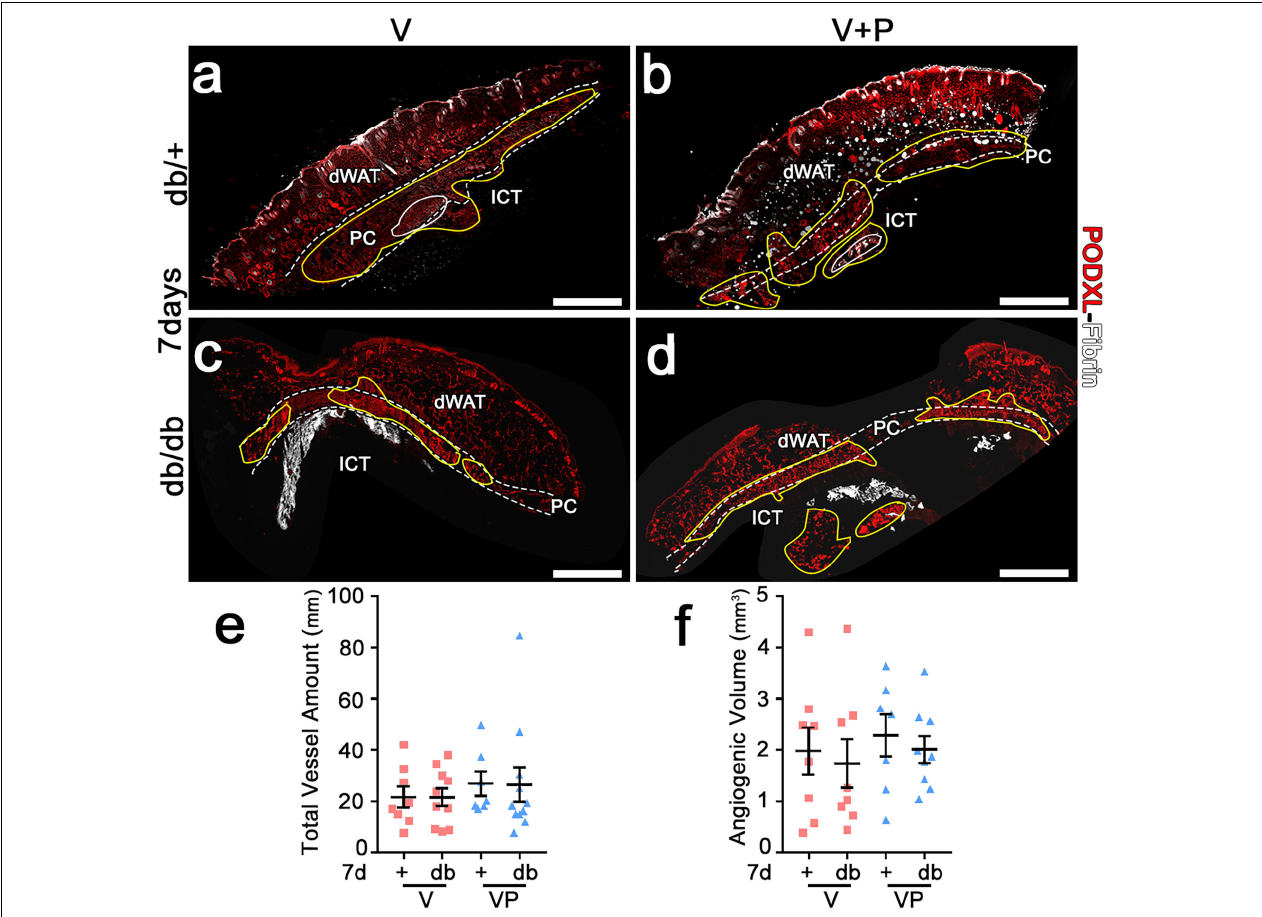
FIGURE 4 | Both VEGF alone and with PDFG-BB enable similar amounts of vascular growth in diabetic skin as in healthy mice. (a–d) Immunostaining for podocalyxin (endothelial cells, red) and fibrin (white) was performed on cryosections of dorsal skin of normal heterozygous (db/+) and diabetic (db/db) mice 7 days after implantation with V and VP gels; dWAT, dermal adipose white tissue; PC, panniculus carnosus; ICT, interstitial connective tissue. The total vessel amount (e) and the total angiogenic volume (f) were quantified in all visible angiogenic areas (marked in yellow in a–d ). Data represent mean values of each sample ± SEM ( n = 8–11 samples/group). Scale bars = 1 mm in all